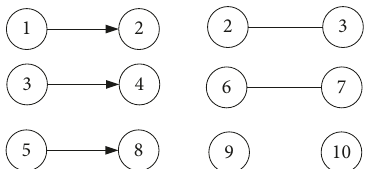
Figure 11: Topological diagram for the precedence and cooperating tasks ( 𝑛 =10).